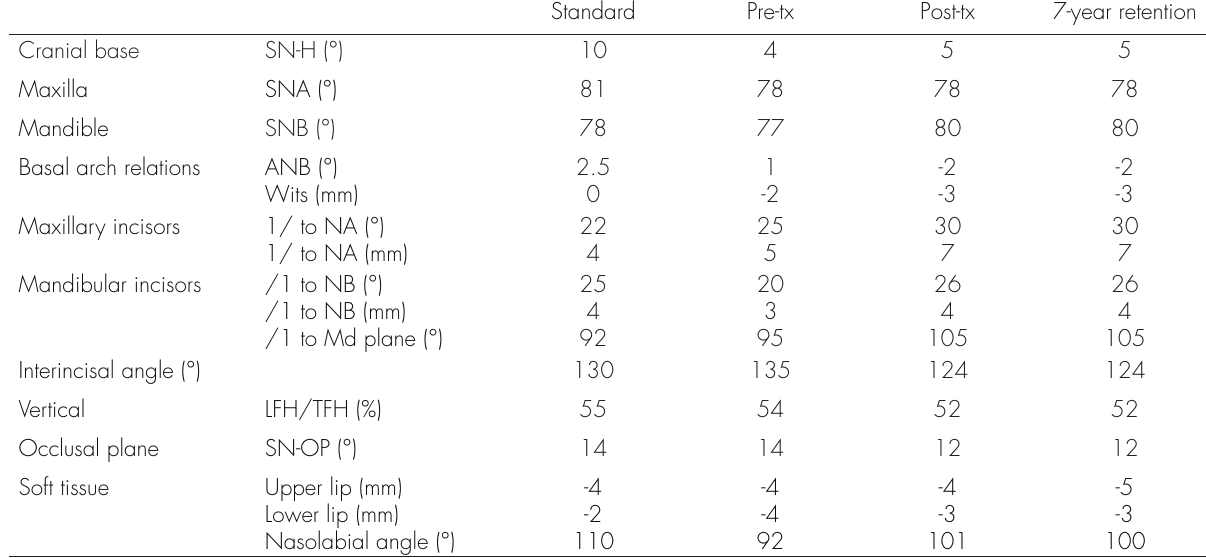
Table I. Cephalometric